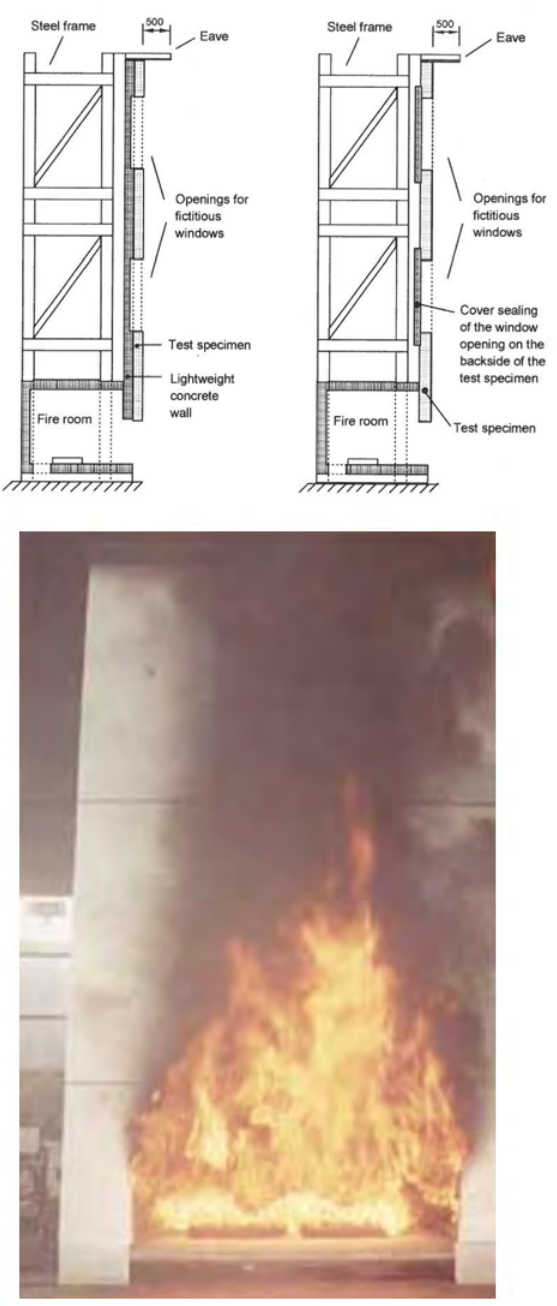
Figure 3: Example of fire test acc. to SP Fire 105